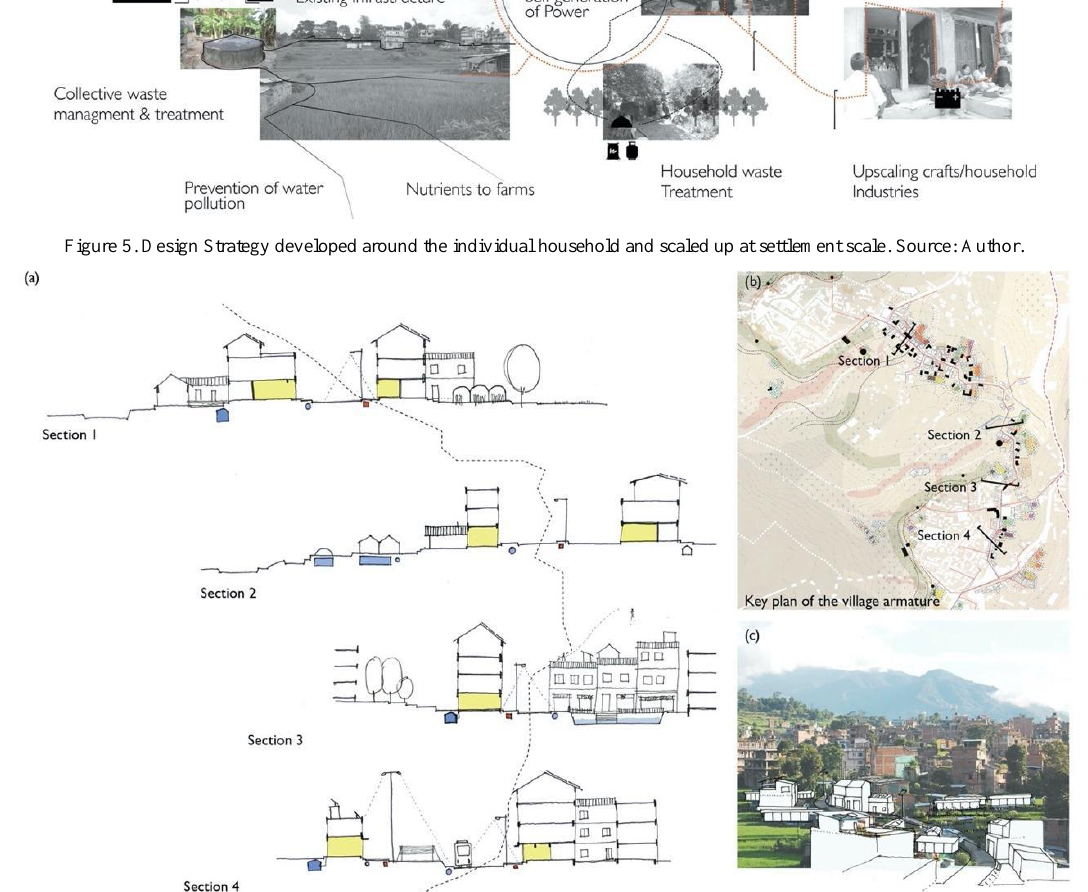
Figure 6. The village-level public path strengthened as the resource armature; (a) Sectional expression; (b) Key plan of the village street highlighting the 'pooling' nature of the village level armature; (c) aerial view of the incremental transformation at an individual level. Source: